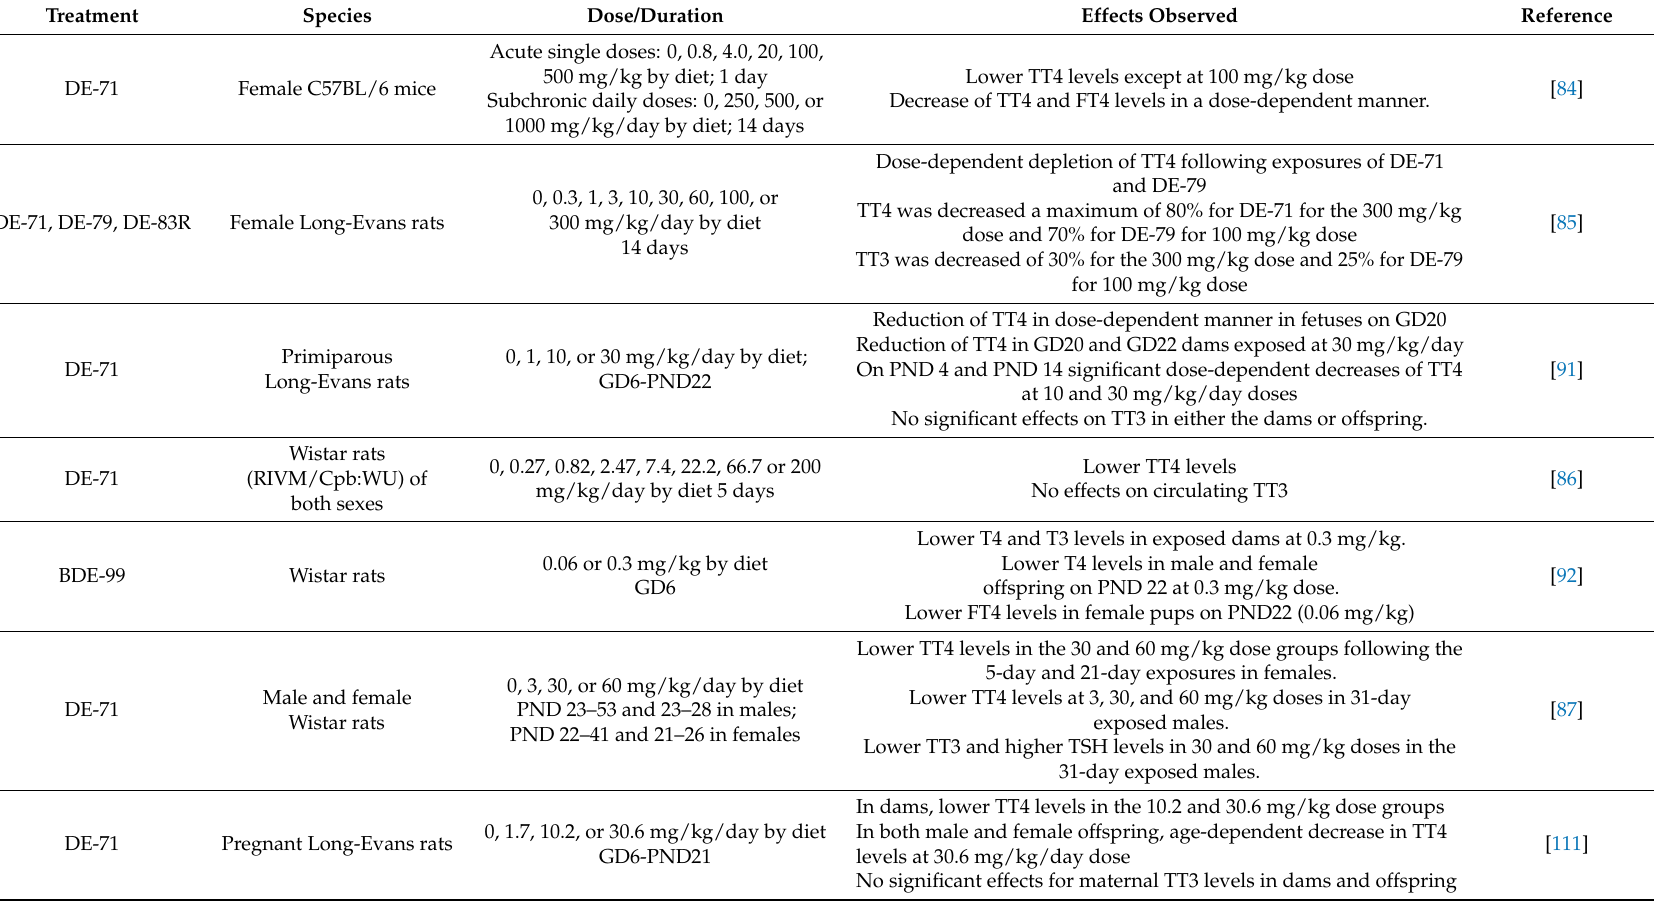
Table 1. Summary of studies in rodents analyzing the effects of polybrominated diphenyl ethers (PBDEs) on thyroid